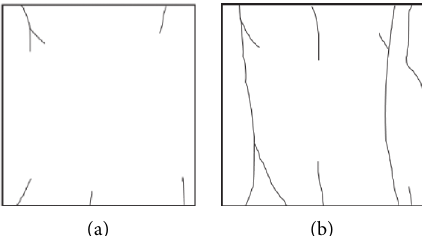
Figure 4: The failure modes of concrete under compression at different stages. (a) Initial failure mode. (b) Final failure mode.